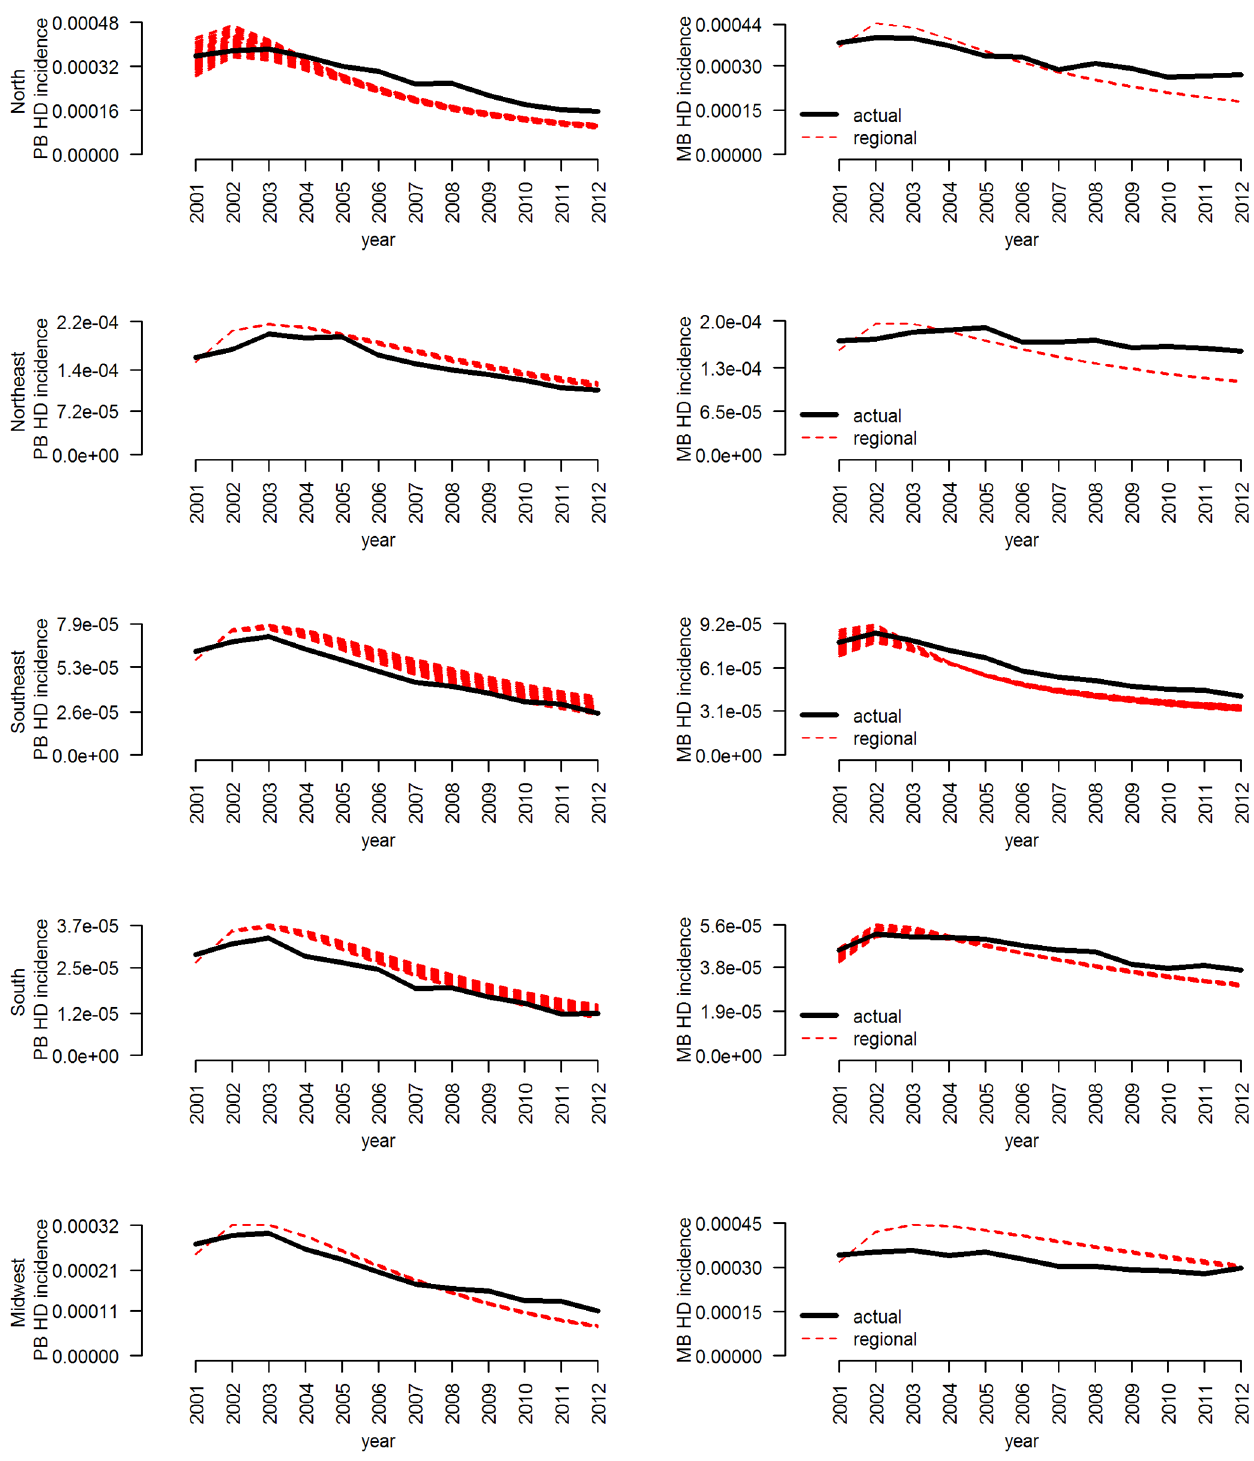
Fig 3. Posterior predictions for incidence and multibacillary (MB) incidence of the compartmental model of Hansen ’ s disease for the regions of Brazil, compared to the observed values for 2000 – 2012. Unknown parameters were fitted to each region individually. All models were fit using Approximate Bayesian Computation with the Sequential Monte Carlo